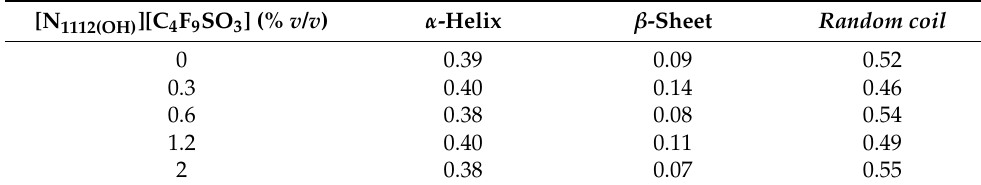
Estimation of secondary structure content of hPAH at different concentrations of